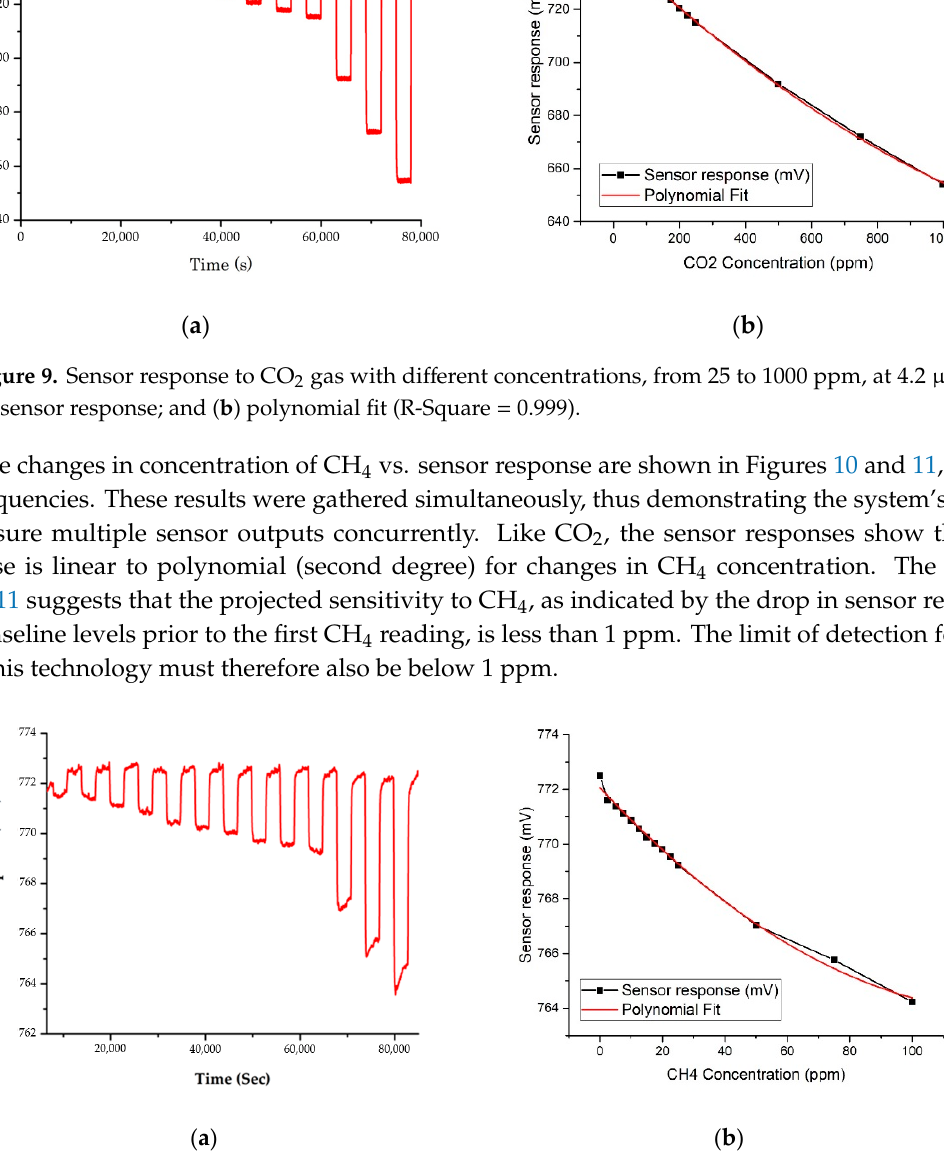
Figure 10. Sensor response to CH 4 gas with different concentrations, from 2.5 ppm to 100 ppm, at 3.4 µm: ( a ) sensor response; and ( b ) polynomial fit (R-Square = 0.995).